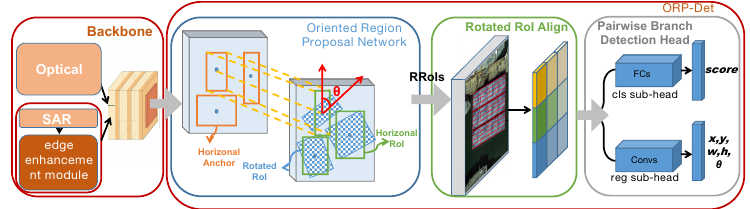
Figure 1. Overview of the proposed framework for ship detection.